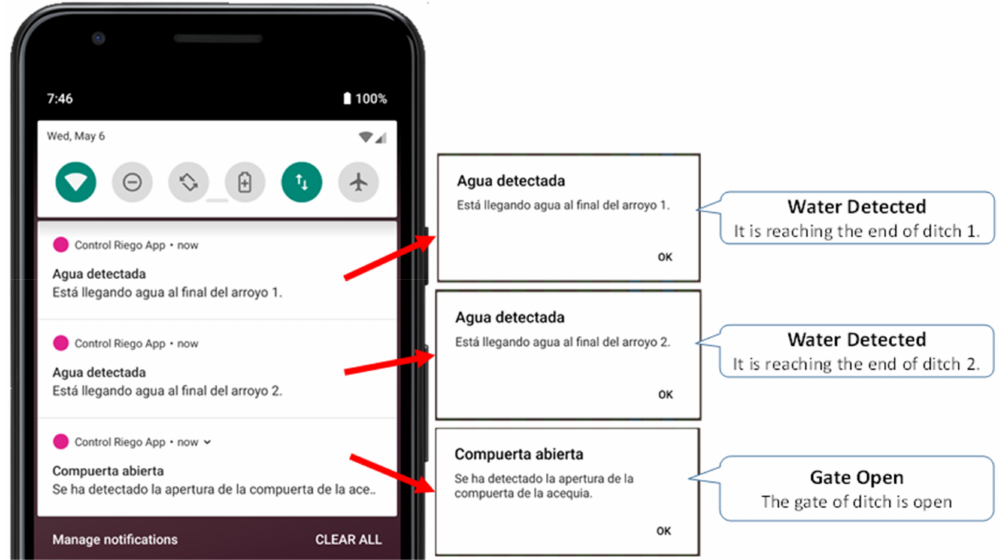
Figure 14. Notifications of water detection and gate opening.